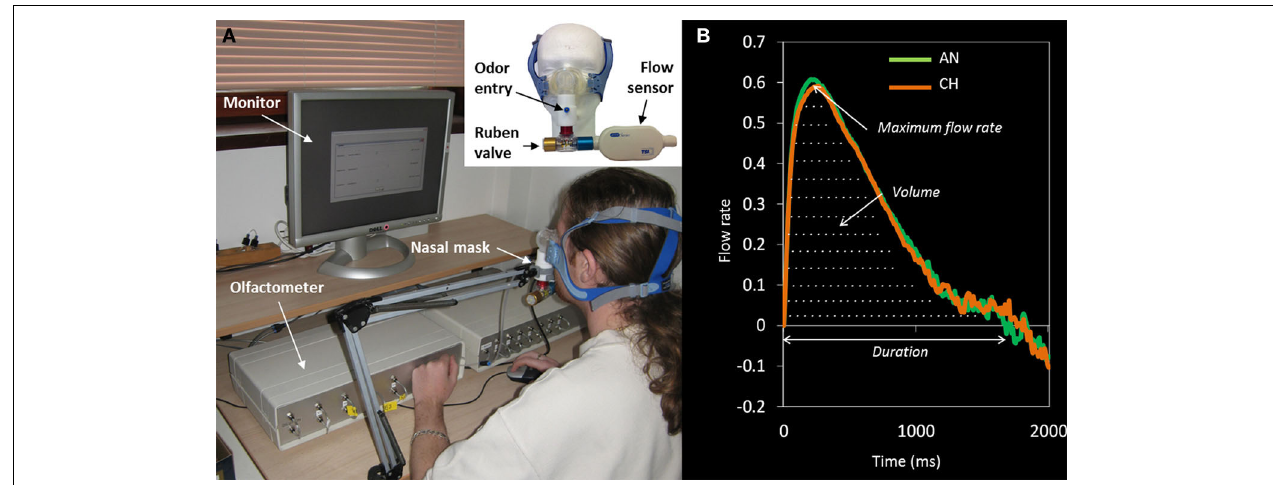
FIGURE 1 | (A) Experimental device ensuring odor delivery and sniff recording. Nasal respiration was monitored with a flow sensor connected both to the subject’s nose via a nasal mask and to the olfactometer. The nasal inspiration, detected by the flow sensor, triggers the sending of the odorant by the olfactometer during the requested duration to the subject’s nose. To clean the mask chamber between stimulations, and to decrease